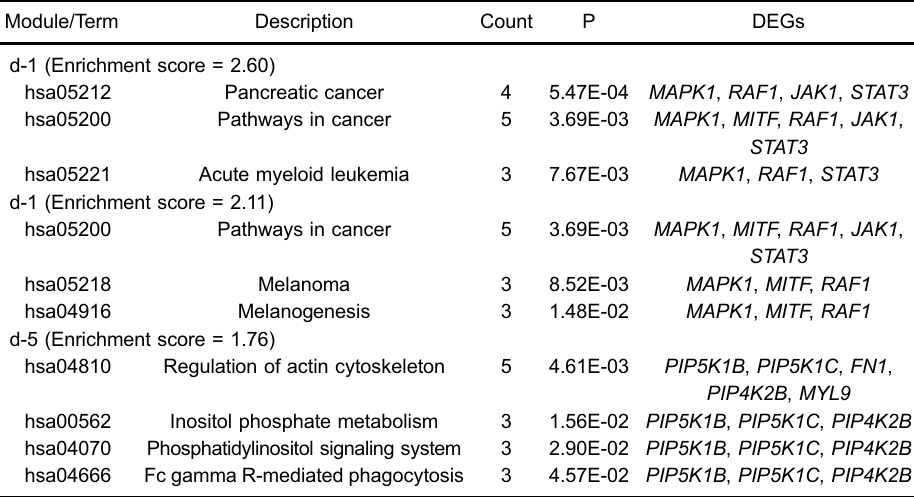
Table 5. Enriched KEGG pathways for genes in downregulated modules with a higher enrichment